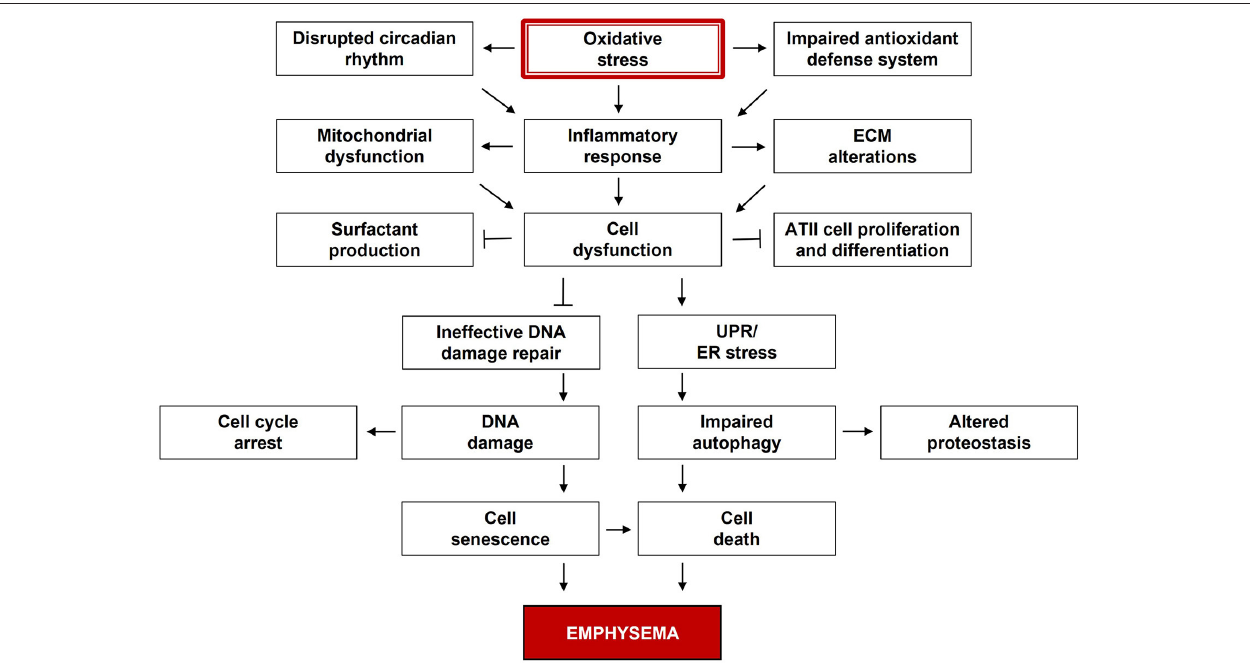
FIGURE 1 | Multiple dysregulated signaling pathways in the pathogenesis of emphysema. Oxidative stress is the major contributor to emphysema. Reactive oxygen species (ROS) and related species disturb cell signaling and impair cell functions, while the antioxidant defense system is overwhelmed. These components are dynamically and progressively interactive over time, and their alterations can lead to emphysema